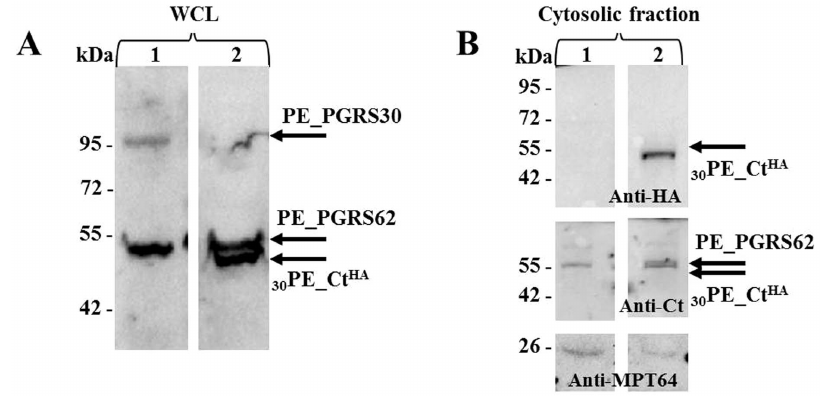
Figure 4. Immunoblot showing expression of PE_PGRS30 by Mtb . A) Immunoblot analysis on whole cell lysates of Mtb expressing PE_PGRS30 and its HA-tagged chimeras with anti-C-terminal domain primary antibody. B) Immunoblot analysis on cytoplasmatic fraction of Mtb expressing PE_PGRS30 and its HA_tagged chimeras probed with anti-HA antibody, anti-C-terminal domain and anti-MPT64 sera; 1: Mtb -PE_PGRS30 HA ; 2: Mtb - 30 PE_CT HA ; Arrows indicate the band corresponding to PE_PGRS30 HA and PE_CT HA and PE_PGRS62.